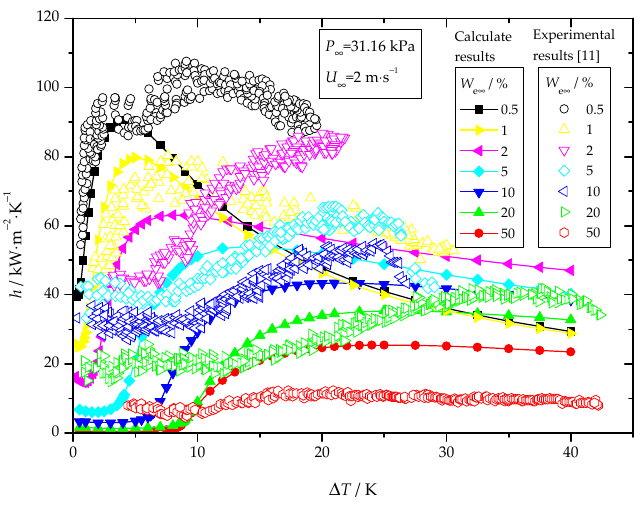
Figure 6. Comparison of condensation heat transfer coefficients between the calculation results and the existing experimental results.